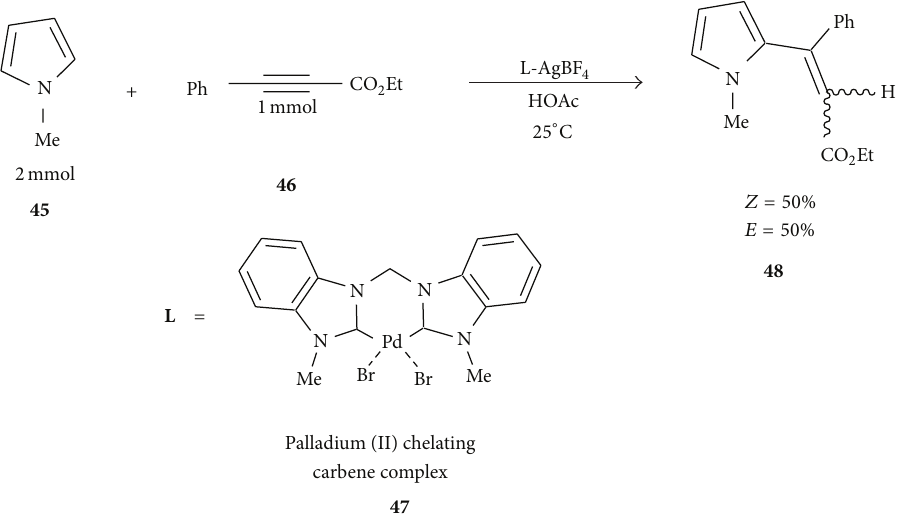
Scheme 7: Pd carbene complex AgBF 4 -mediated synthesis of compound 48 .